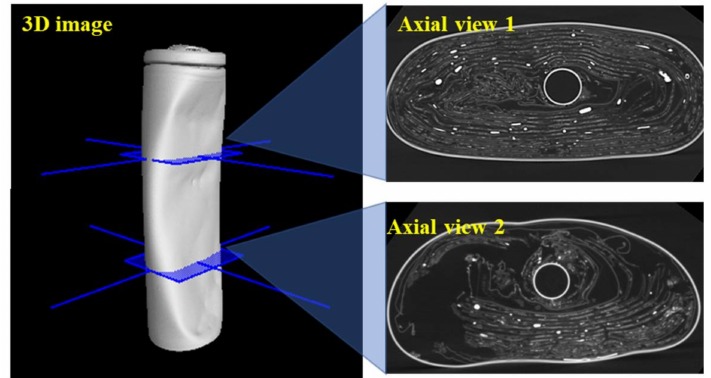
Figure 12. Axial views with and without the negative tab of the sample A1.